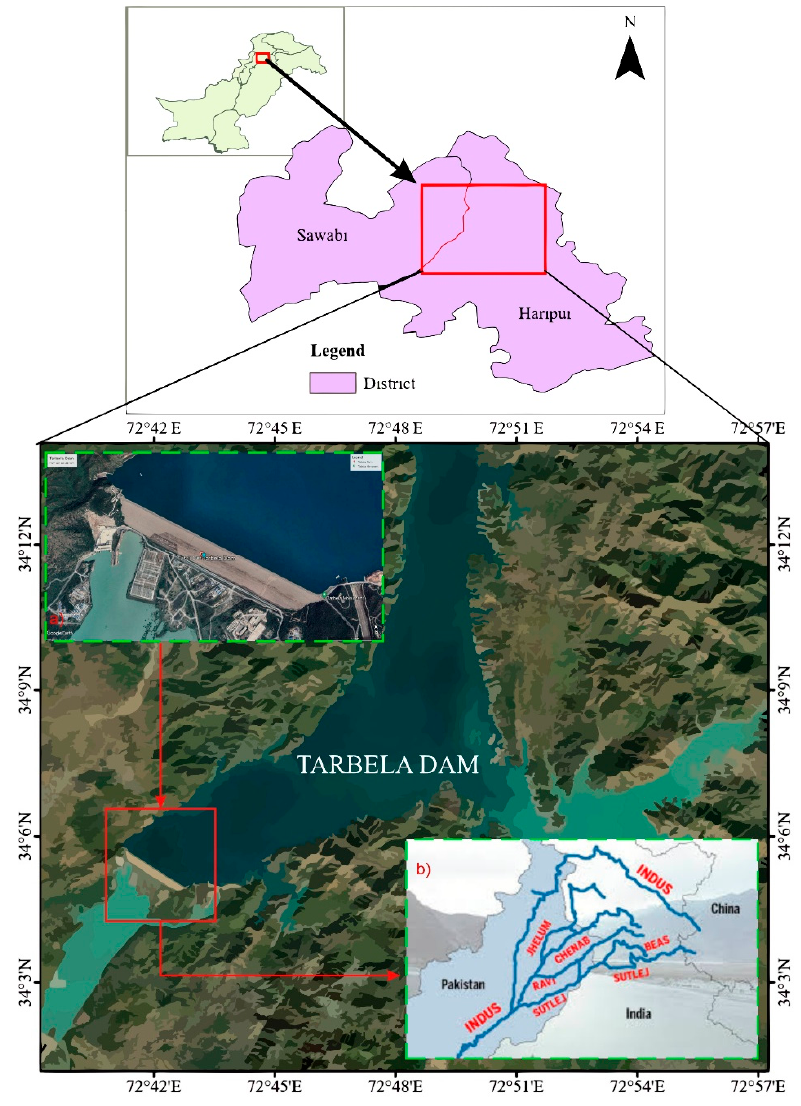
Figure 1. The study area of earth-fill Tarbela dam of Pakistan. ( a ). Tarbela dam main embankment Google Earth overview. ( b ). Origin and overview of Indus River, which inflows into dam reservoir.